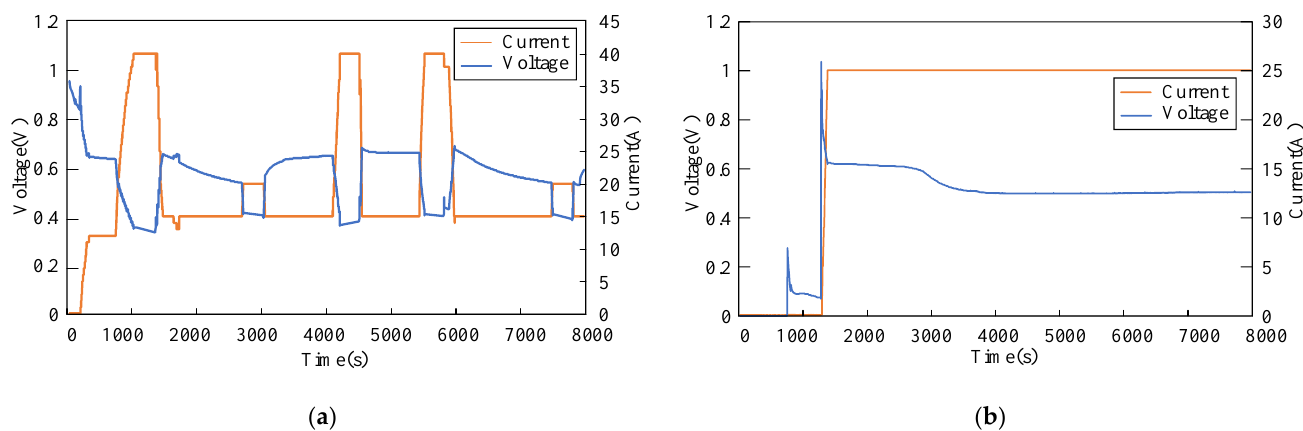
Figure 2. Voltage and current diagram of PEMFC water flooding and membrane dry experiment: ( a ) water flooding; ( b ) dry membrane.